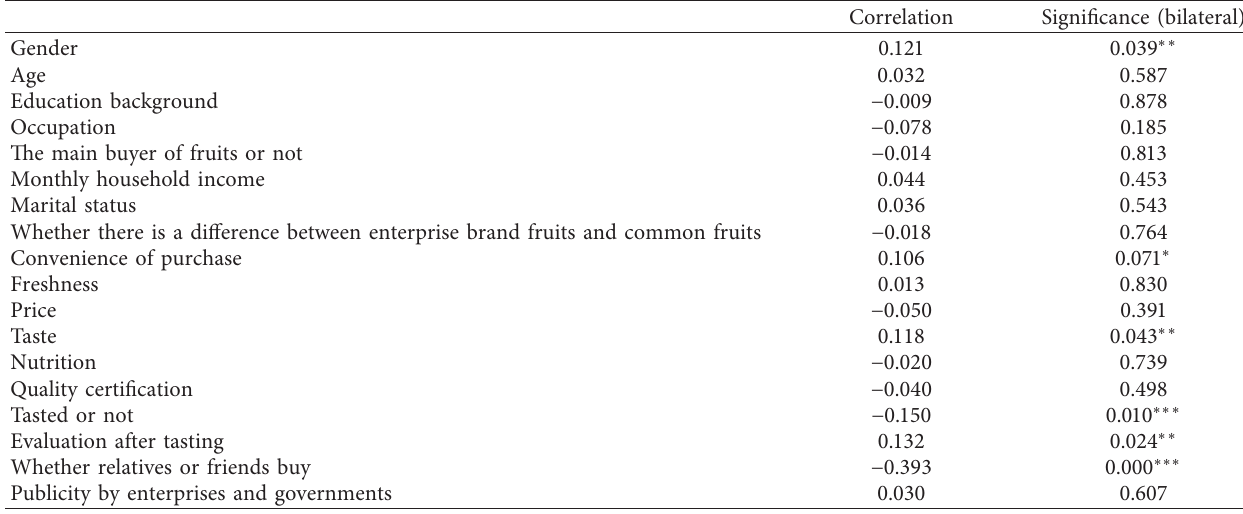
Table 8: Correlation test between the factors influencing the behavior of purchasing enterprise brand fruits and the dependent variable.